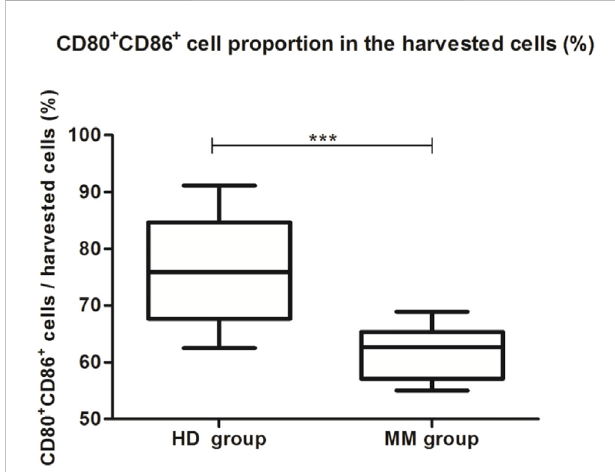
The proportion of moDCs in the harvested cells between the HD group and the MM group. The boxplot shows that the proportion of moDCs in the harvested cells in the HD group was signi fi cantly higher than in the MM group (75.55% ± 9.69% vs. 61.39% ± 4.86%, p = 0.000, independent-sample t -test).